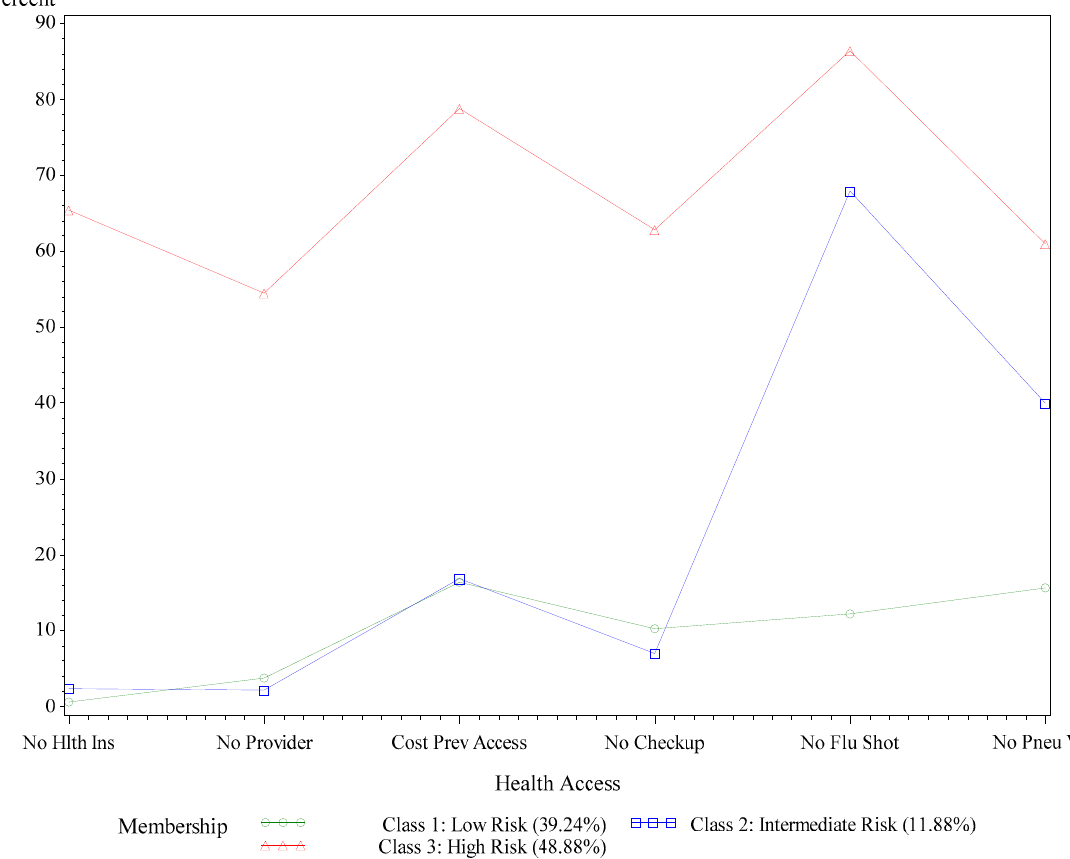
Figure 4. Probabilities of limited healthcare access by latent class, AL adults with COPD, BRFSS, 2015–2019. No Hlth Ins is defined as a response of “No” healthcare coverage, including health insurance, prepaid plans such as HMOs, or government plans such as Medicare or the Indian Health Service. No Provider is defined as a response of “No” when asked if there was a person the respondent could identify as a personal doctor or healthcare provider. Cost Prev Access is defined as a response of “Yes” when asked if there was a time in the past 12 months when the respondent needed to see a doctor but could not because of cost. No check-up is defined as not visiting a doctor for a routine check-up within the past 12 months. No flu shot is defined as not receiving a flu shot or flu vaccine during the past 12 months. No Pneu Vac is defined as never receiving a pneumococcal vaccine.